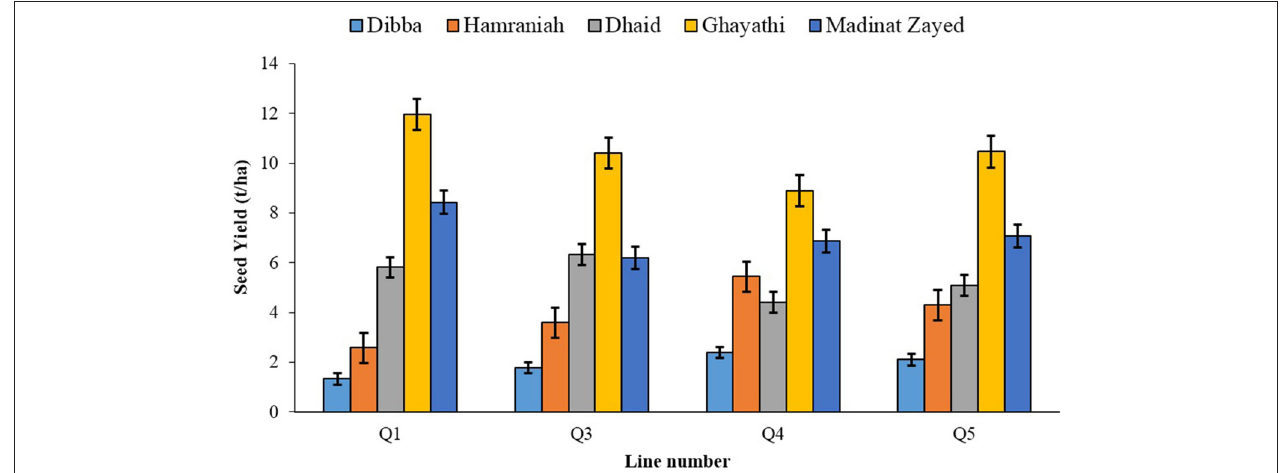
FIGURE 1 | The mean seed yields of four quinoa lines grown at five locations in the UAE during 2013-14. The error bars represent LSD of the means ( p < 0.05) ( Rao, 2016).